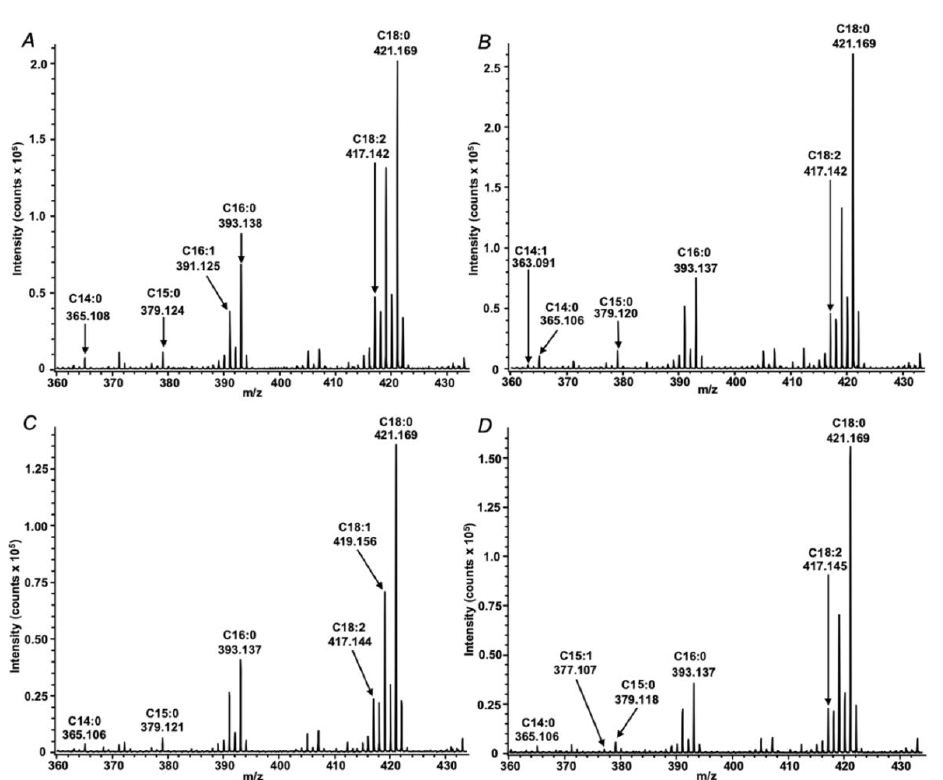
Figure 3. MALDI-TOF mass spectra of extracts obtained from aqueous ( A , B ) and n -hexane ( C , D ) lysates of Rhizobium leguminosarum bv. viciae RCAM1026 ( A , C ) and Sinorhizobium meliloti RCAM1021 ( B , D ) cells.